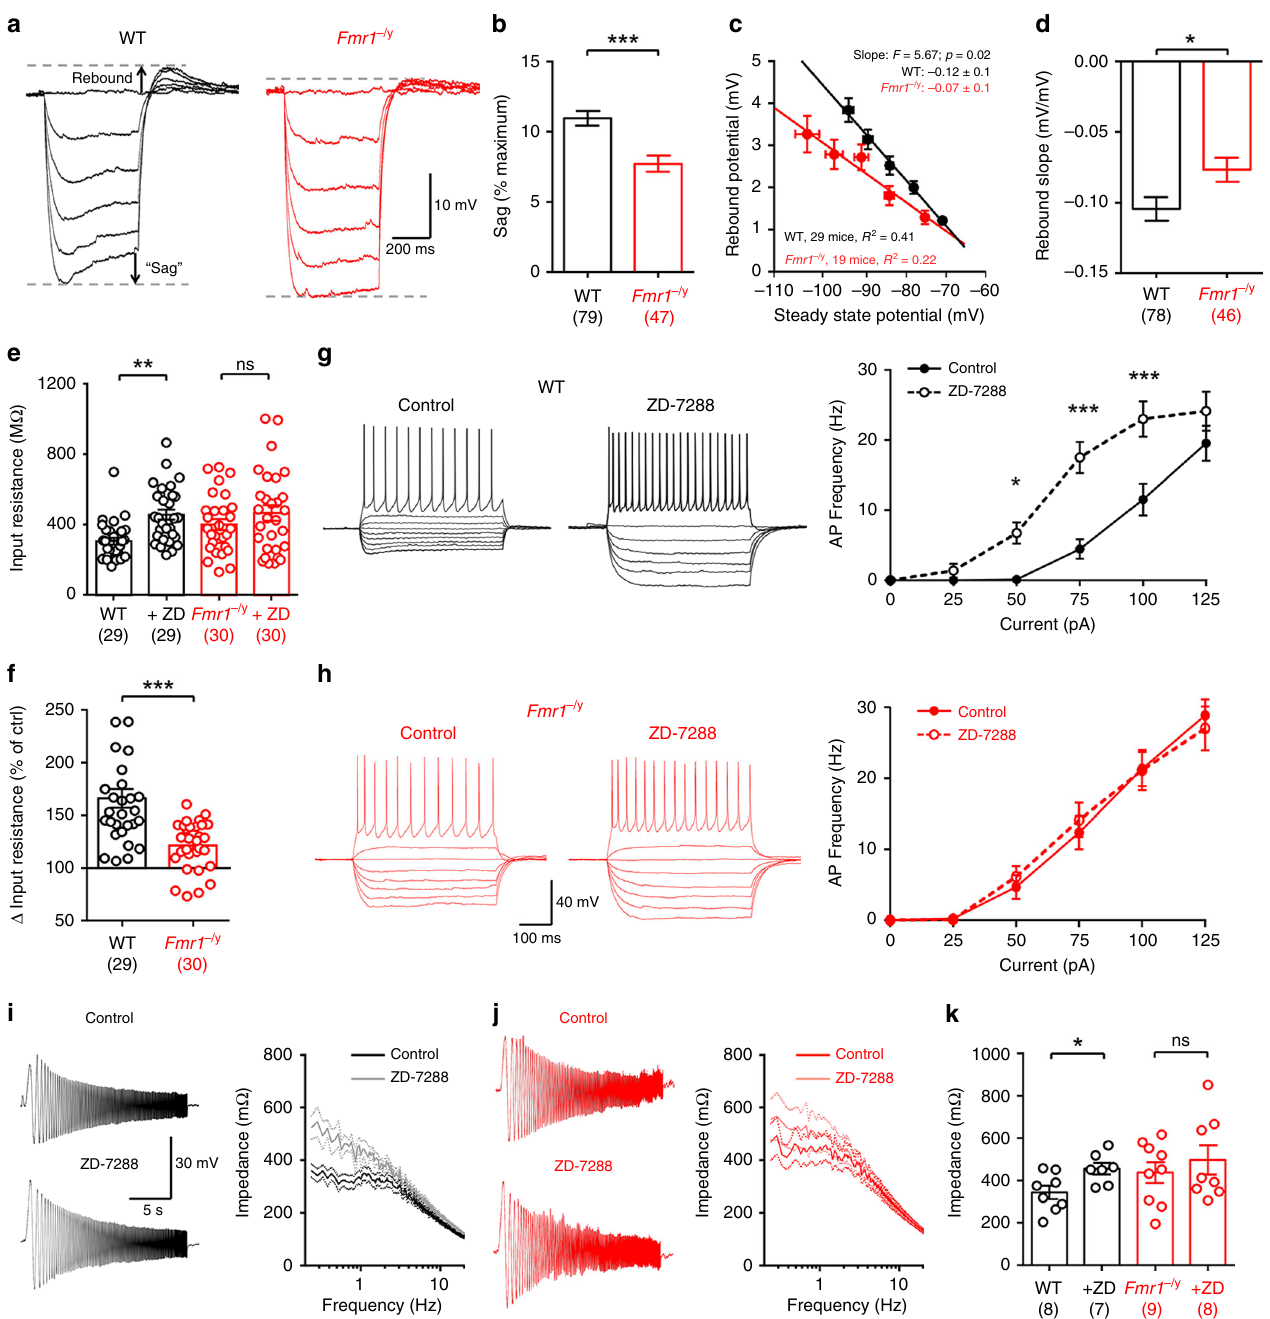
Fig. 7 I h is reduced in L4 SCs from Fmr1 − /y mice, resulting in hyperexcitability. a Hyperpolarizing steps in L4 SCs (0 to − 125 pA, 25 pA steps, 500 ms duration) with voltage “ sag ” and rebound potential indicated, as measured in WT (black, left) and Fmr1 − /y mice (red, right). b Quanti fi cation of voltage sag expressed as % of maximum voltage for WT and Fmr1 − /y L4 SCs c plot of rebound potential, as a function of steady-state voltage for WT and Fmr1 − /yS L4 SCs, fi tted with linear regression and with fi t values displayed. d quanti fi cation of the rebound slope of individual L4 SCs for both genotypes. e R I measured before and after bath application of the I h blocker ZD-7288 (ZD; 20 µ M) in WT and Fmr1 − /y L4 SCs. f Change in R I change following ZD application (as 100% of control levels). g (left) Hyper- to depolarising current steps ( − 125 to + 125 pA, 25 pA steps, 500 ms duration) in WT L4 SCs before and after ZD application. g (right) Current – frequency plot of AP discharge before (solid lines) and after (dashed lines) ZD application. h The same analysis as in ( g ), but in Fmr1 − /y L4 SCs. i Subthreshold membrane chirps (0.2 – 20 Hz, 50 pA, 20 s duration) and current – impedance plot for WT L4 SCs before (black) and after (grey) ZD application. j The same data as in ( f ), but in Fmr1 − /y mice. k Impedance measured at peak resonant frequency in WT and Fmr1 − /y L4 SCs before and after ZD ( + ZD) application. Statistics shown: ns p > 0.05, * p < 0.05, ** p < 0.01, *** p < 0.001, from LMM ( b , d , e , f , k ). Summary plots of all data shown in ( b ) and ( d ) can be found in Supplementary Fig. 7. All data are shown as mean ± SEM and source data for all plots are provided as a Source Data fi